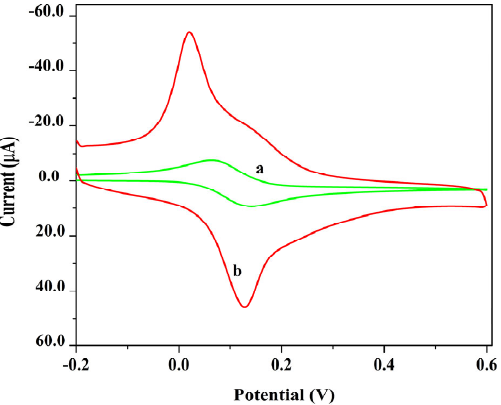
Figure 3. CV of 1.0 mM K 4 Fe(CN) 6 in a probe of 0.1 M KCl on EPGNLCPE ( a ) and BCPE ( b ).